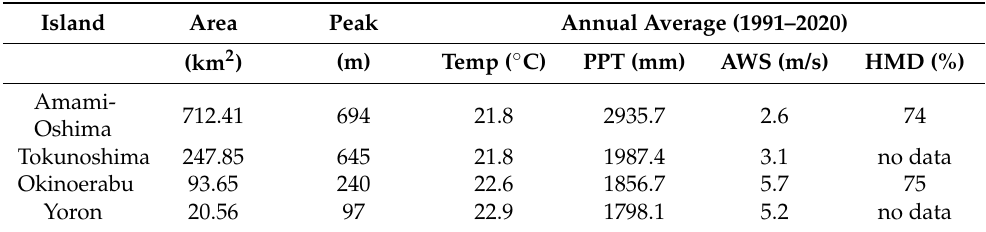
Table 1. Regional and meteorological characteristics of four Amami islands. Island Area